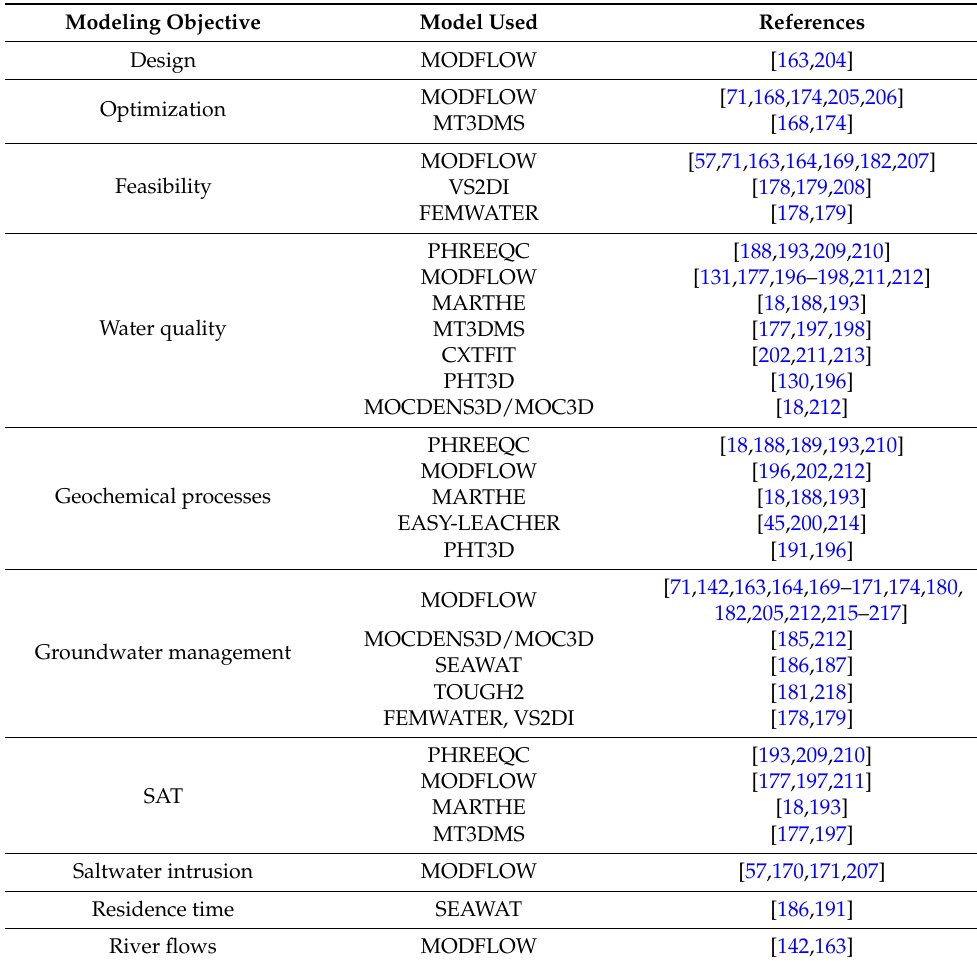
Table 4. List of models which were applied more than once for the different modeling objectives for the MAR technique spreading